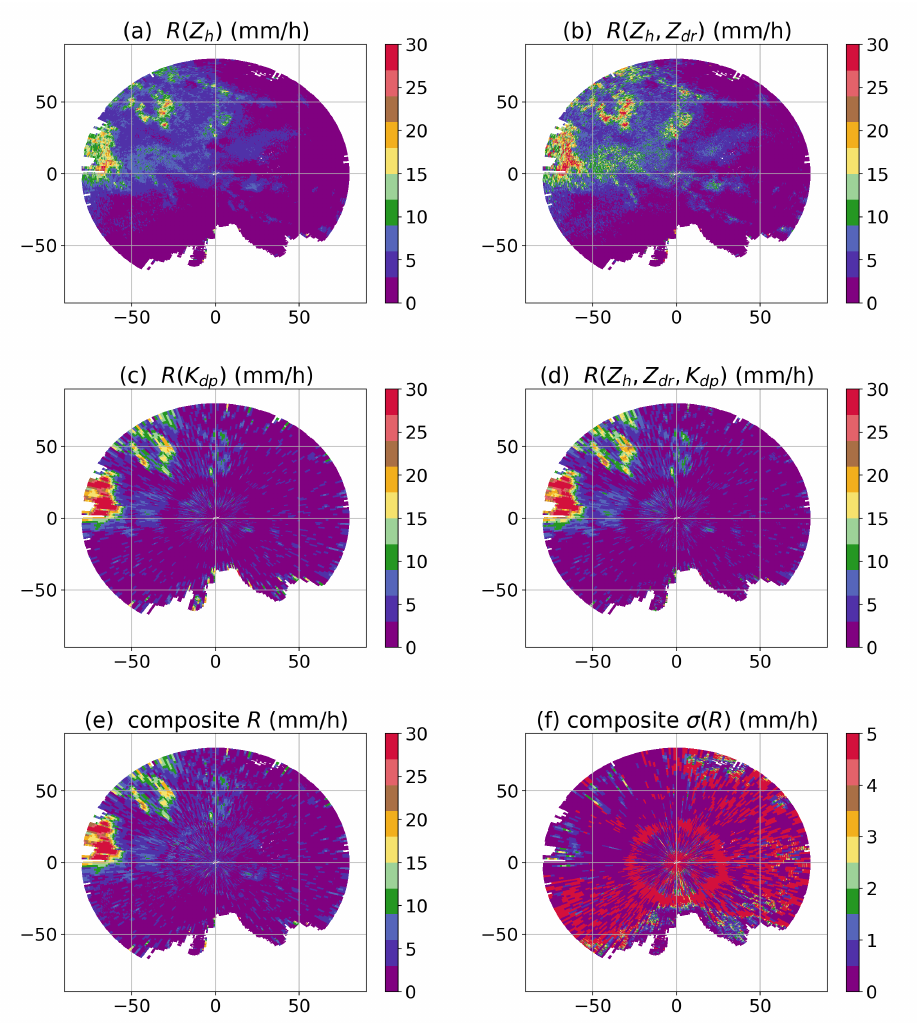
Figure 8. Same as Figure 5, but the data were collected at 0339 UTC on 3 July